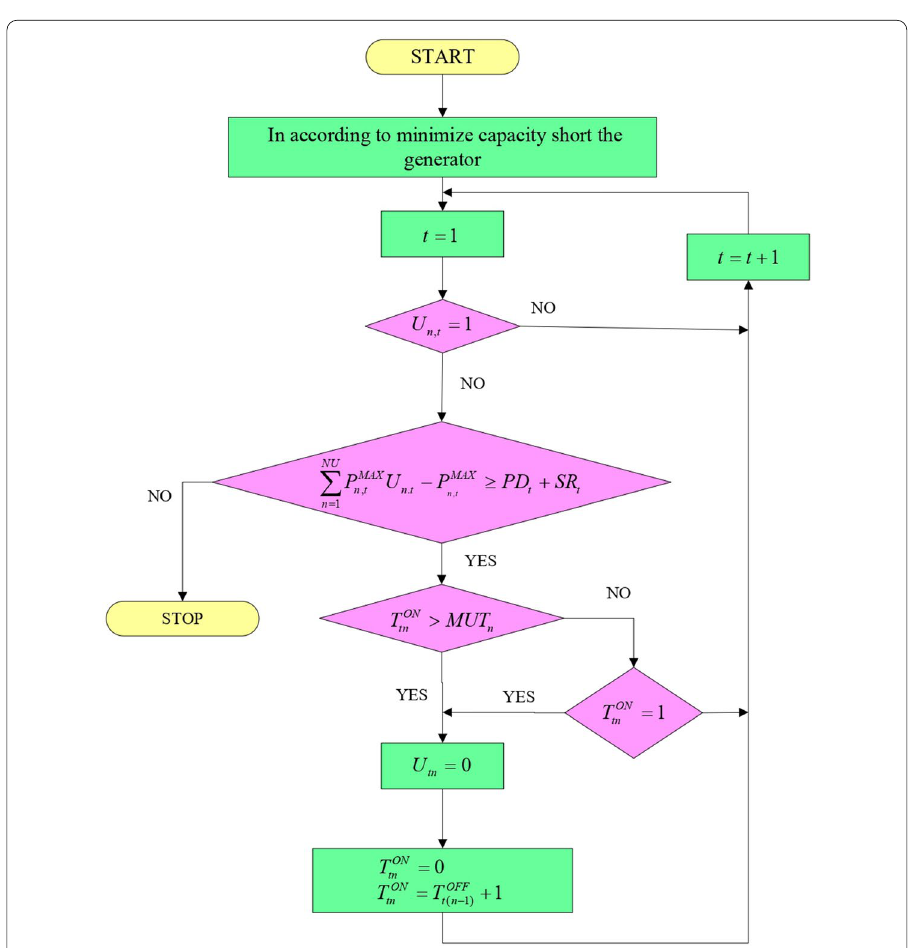
Fig. 7 Flowchart of handle minimum uptime–downtime